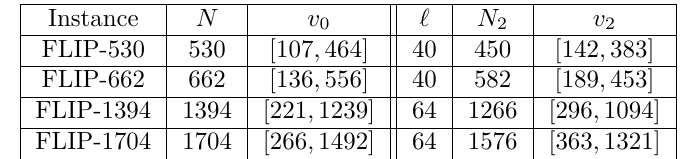
Table 3: Lower bound on NL E v 0 the range of weight k for which monomials of the quadratic part by the guess strategy, N 2 and v 2 are the corresponding number of variables and range of